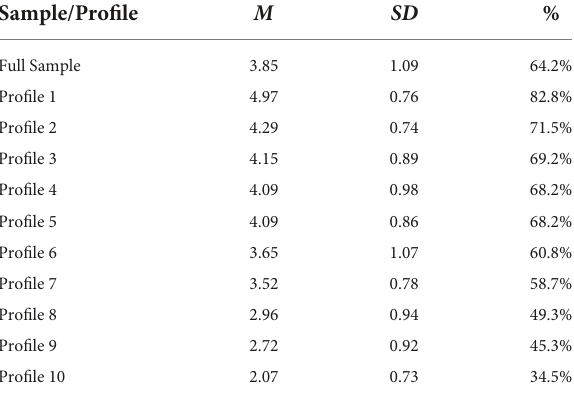
TABLE 4 Unstandardized life satisfaction for the full sample and each